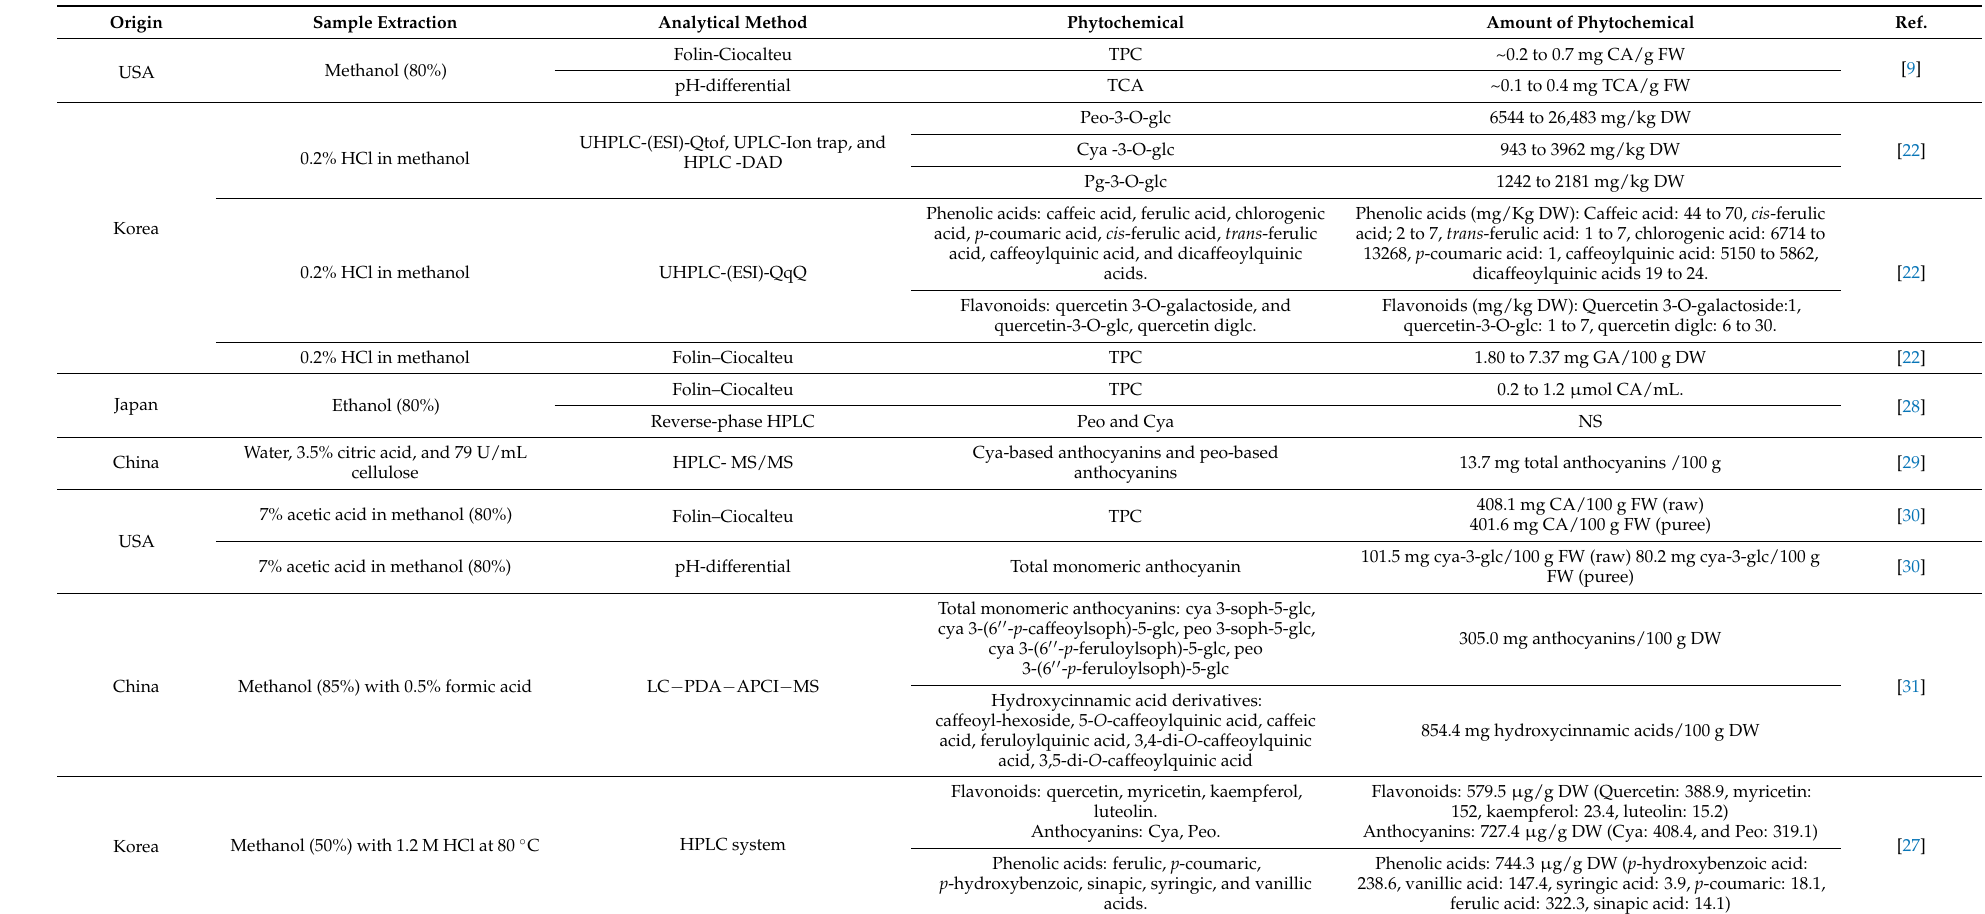
Table 2. (Poly)phenol content of purple sweet potato